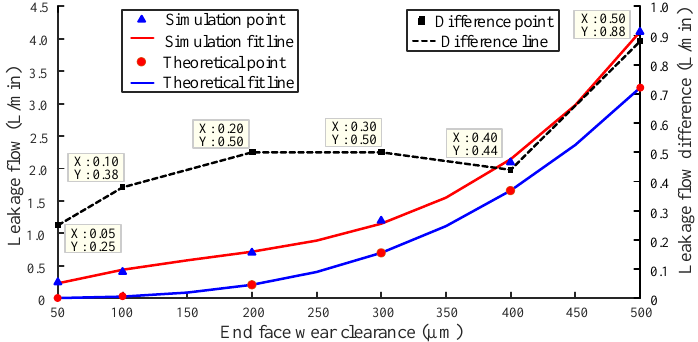
Figure 17. Fitting line of end face wear gap and leakage.